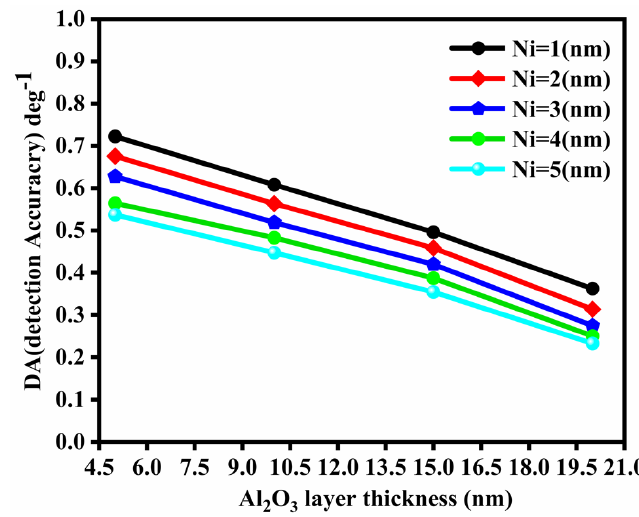
Figure 6. Plot of DA vs. different layer thickness for Al 2 O 3 .